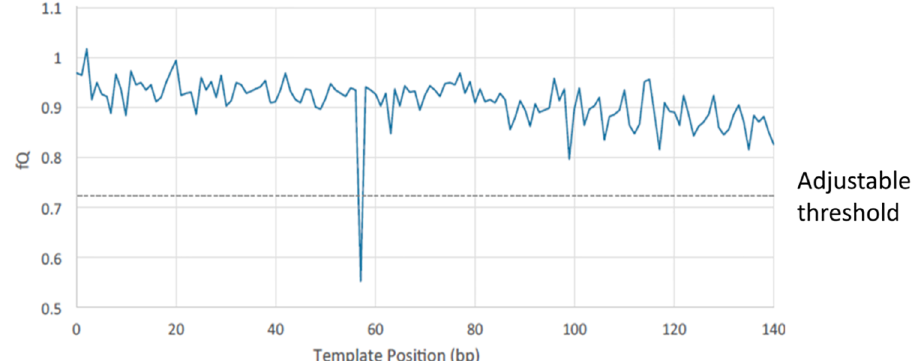
Fig 3. Pro-Seq error identification. In many cases, errors are corrected automatically on the sequencer as they represent a minority sequence compared to the dominant base within a cluster, and are ignored or not detected by the basecaller. To check for errors (mixed bases) that are of similar frequency to the correct base, the relative fluorescence (fQ) is calculated for each base in a read, in such a way that dips represent the presence of a mixed base. An adjustable threshold is used to identify dips and only the mixed base position is then masked. The rest of the read can be trusted to provide high-fidelity sequence information.